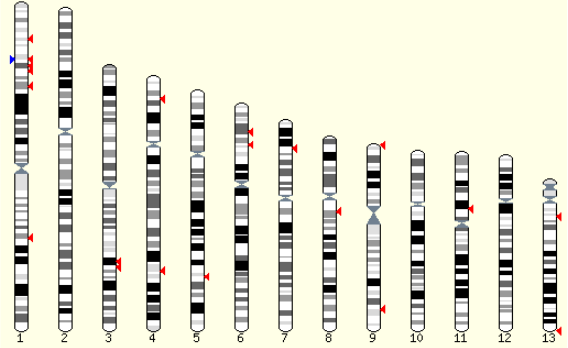
Figure 1: Ensembl: a probe (triangle) on several human chromosomes. The map provides context for this probe, and shows that it is not